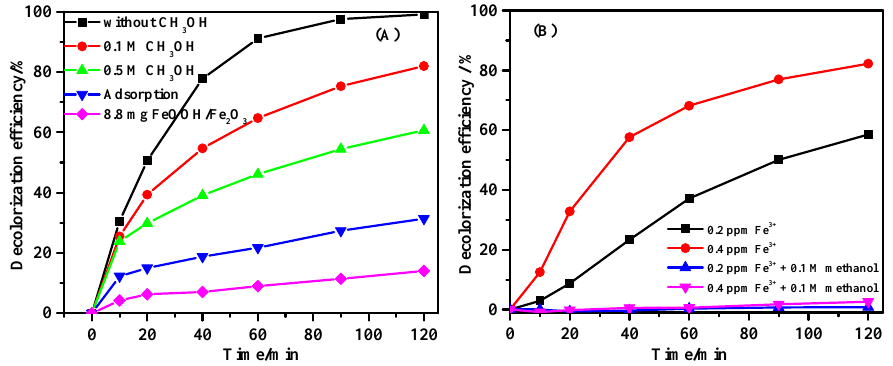
Figure 6. Decolorization of ARG using Fe@CC supplemented with ethanol or using FeOOH/Fe 2 O 3 prepared by hydrothermal ( A ), and decolorization of ARG by homogeneous Fenton reaction using Fe 3+ or Fe 3+ supplemented with 0.1 M methanol ( B ).